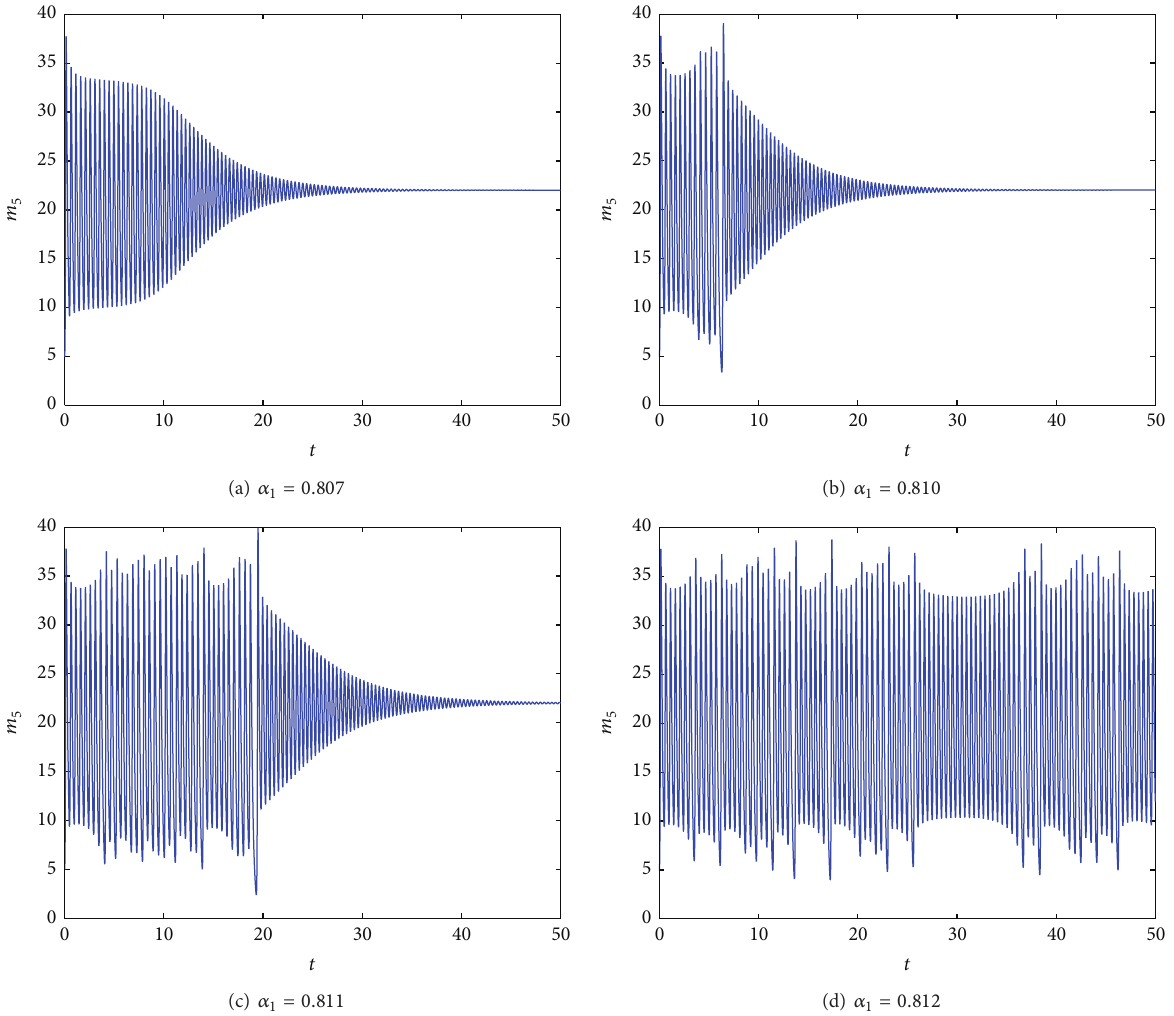
Figure 6: Time histories showing the rout to chaos via intermittency for system (5) at 𝛼 2 = 𝛼 3 = 1 with 𝛼 1